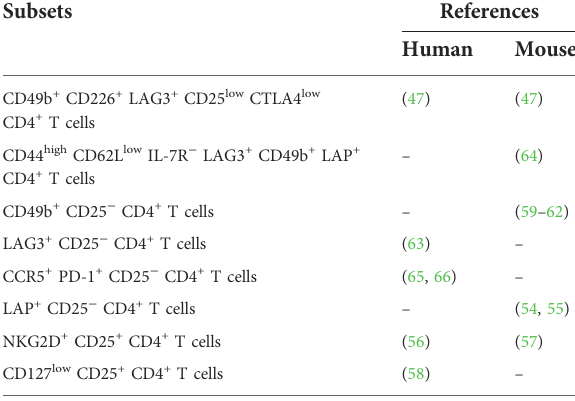
TABLE 2 Phenotypes of Tr1 cells in humans and mice.